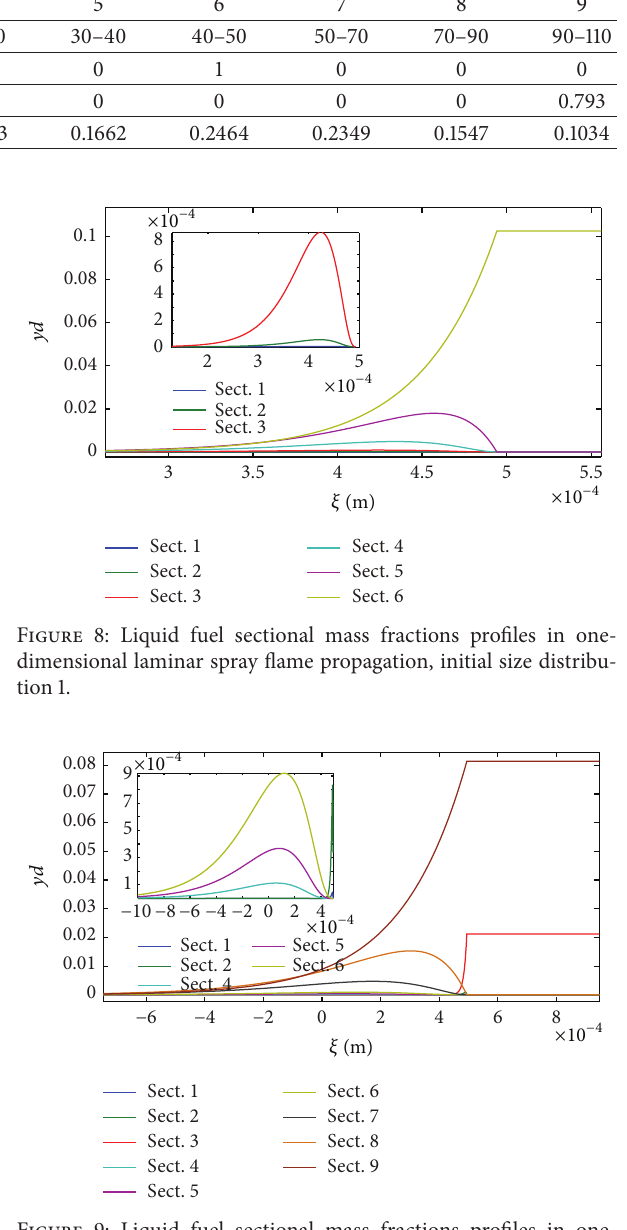
flame reaction zone. The redistribution of liquid